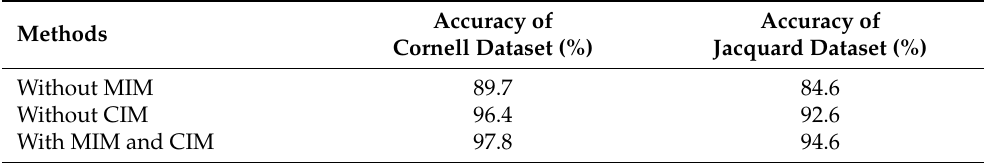
Table 4. Object-wise grasp detection results of ablation experiment on Cornell and Jacquard datasets.